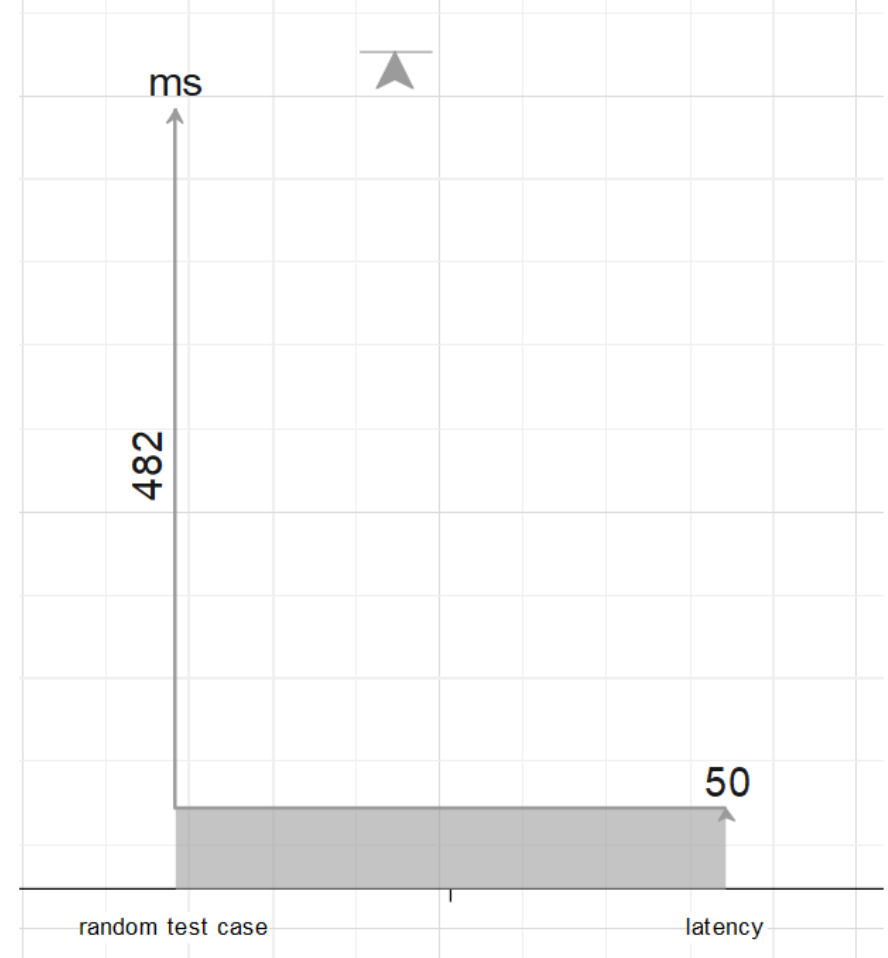
Figure 11. The construction costs of the proposed method, taking into account the latency of the network.